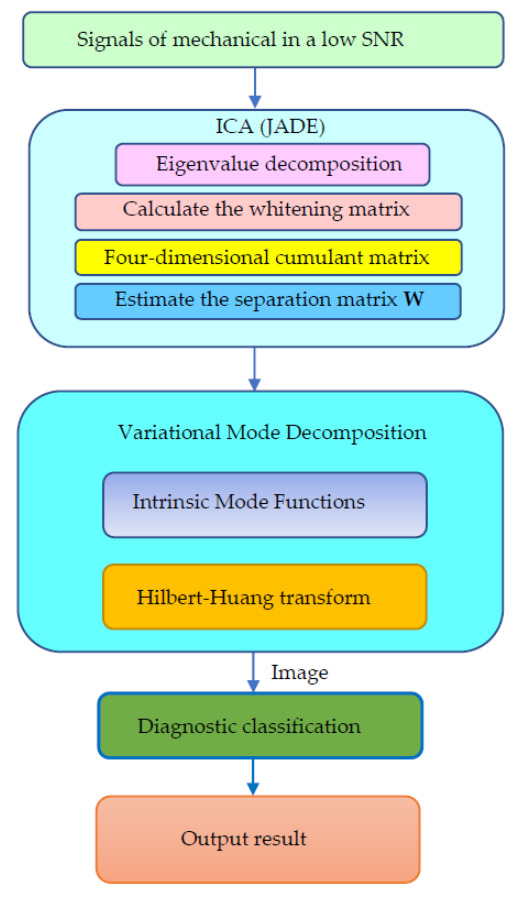
Figure 1. The entire flowchart of